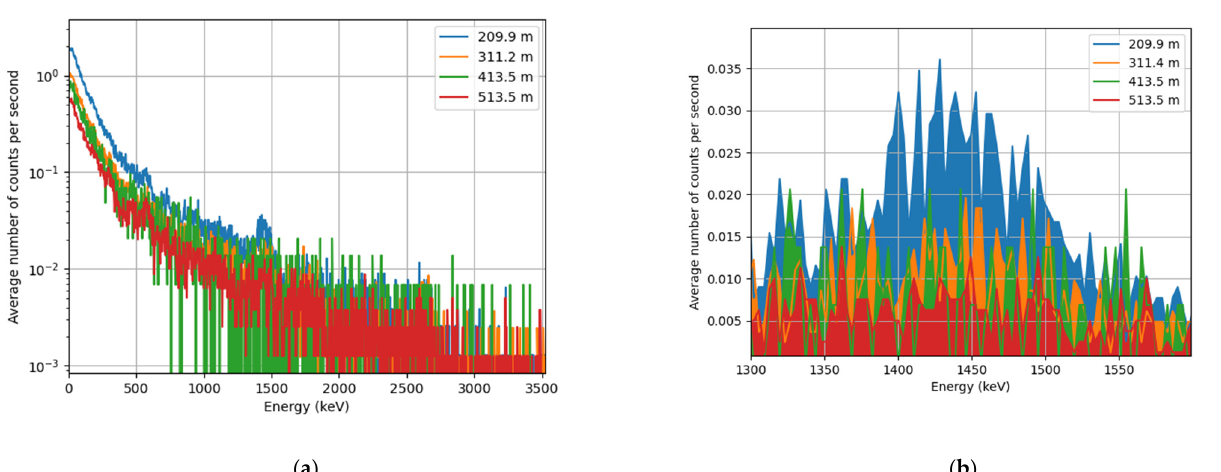
Figure 10. Total number of counts per second compared to the height above ground level in m for flight 1 ( a ) and flight 2 ( b ).